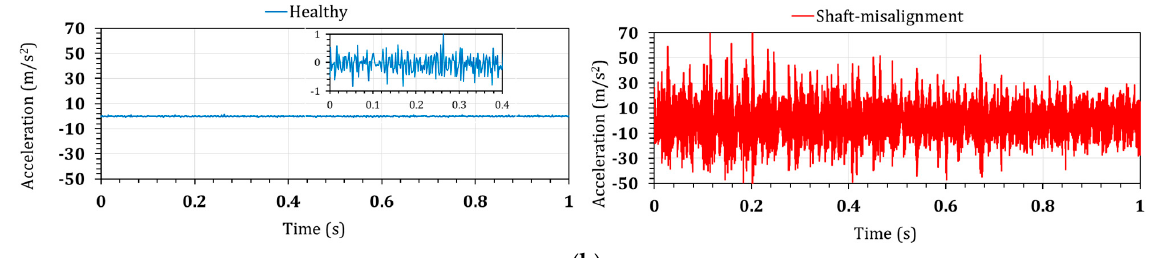
Figure 16. ( a ) The measured acceleration in the Z-direction for the shaft-misaligned DC motor, and ( b ) comparison of the acceleration in healthy and shaft-misalignment conditions.